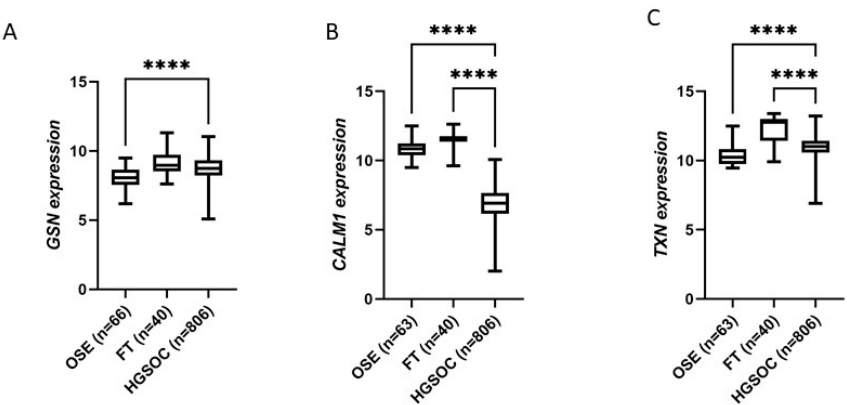
Figure 3. Marker expression in normal tissues compared to HGSOC. GSN ( A ), CALM1 ( B ), and TXN ( C ) mRNA expression data obtained from the GENT2 database including ovarian surface epithelium (OSE) (n = 66), fallopian tube (FT) epithelium (n = 40), and high-grade serous ovarian cancer HGSOC (n = 807). **** p < 0.0001, Kruskal–Wallis with Dunn’s multiple comparison test.